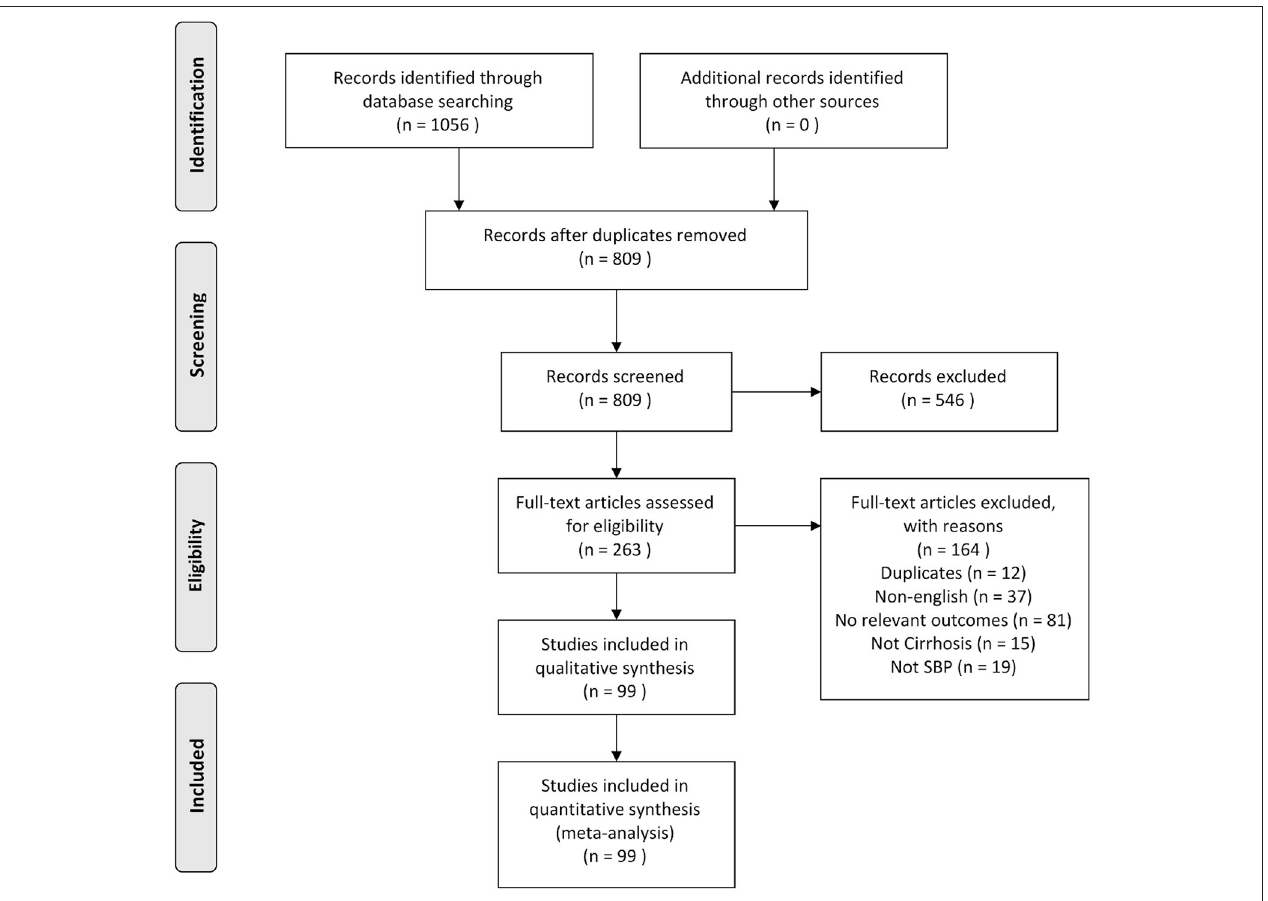
FIGURE 1 | PRISMA flowchart of systematic